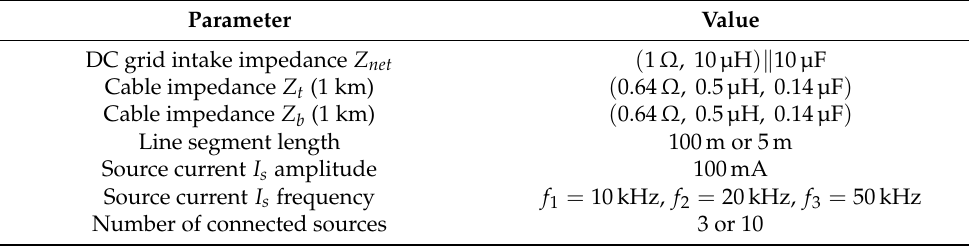
Table 1. Parameters of the Simulink DC grid model and MCM